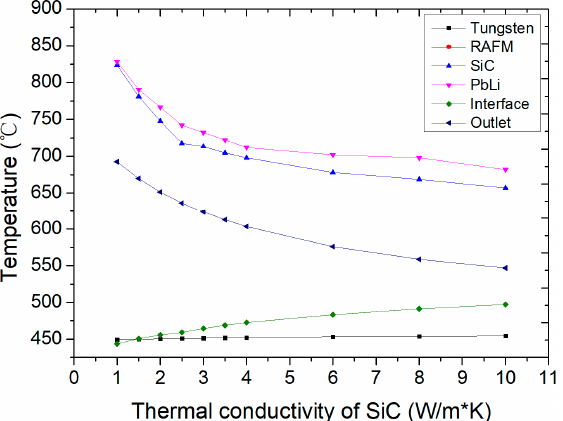
Figure 8. Variation of maximum temperature for different thermal conductivity of SiC.